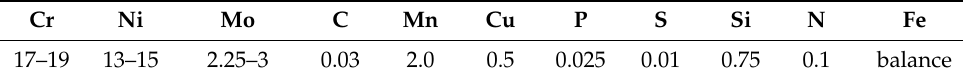
Table 1. Chemical composition of 316L alloy